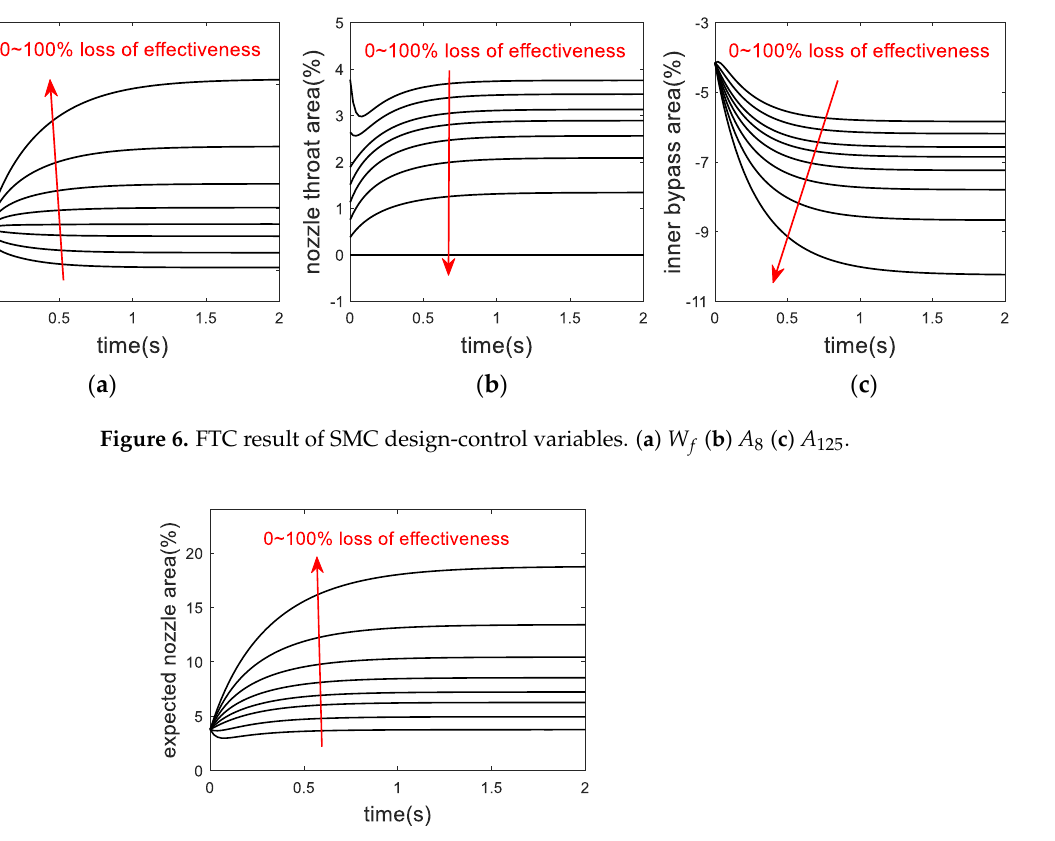
Figure 5. Fault tolerant control (FTC) result of sliding mode control (SMC) design-controlled variables. ( a )